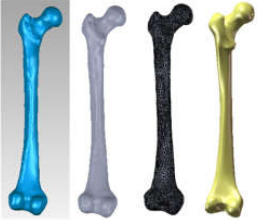
Figure 30. The model of the femur first in Geomagic, then in SolidWorks.